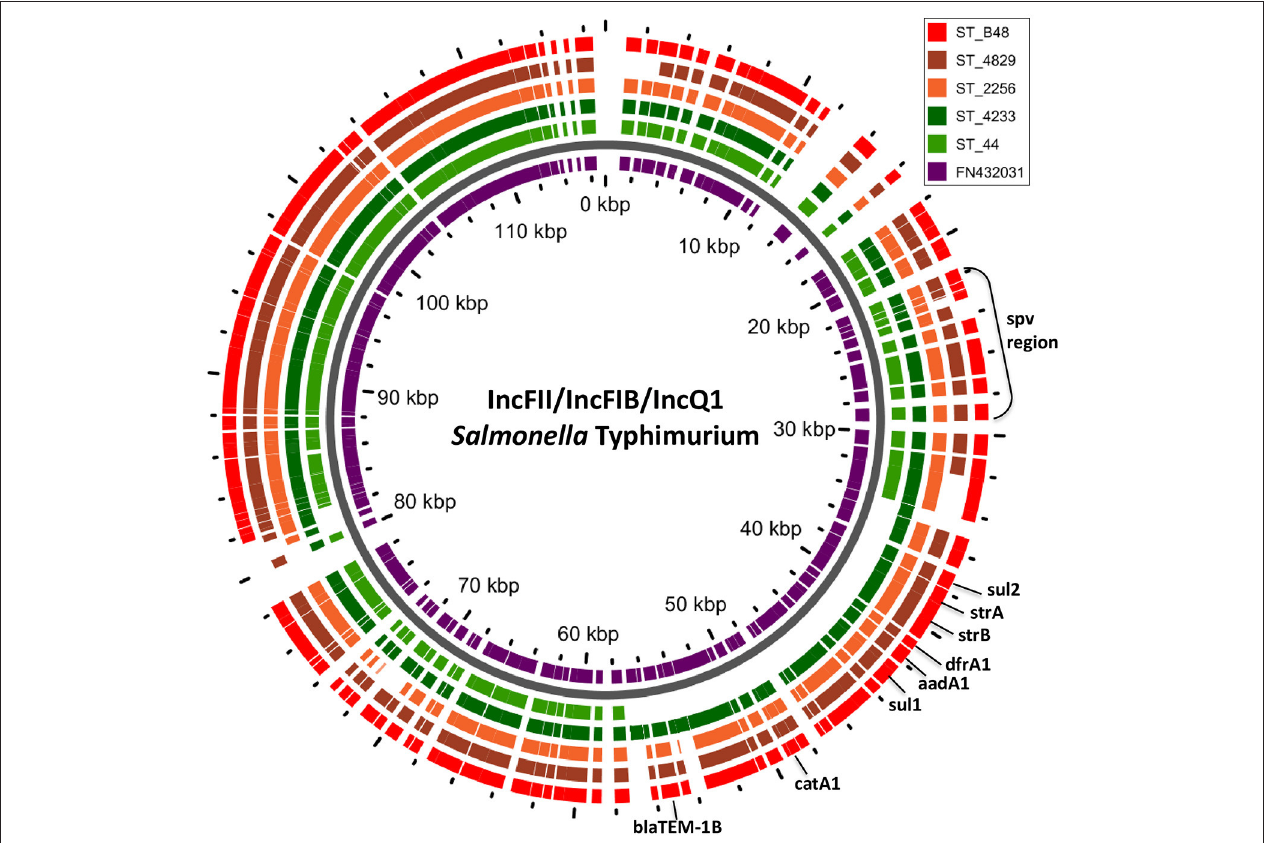
FIGURE 2 | BLAST ring of IncFII(S)/IncFIB(S)/IncQ1 plasmid homologs of Salmonella Typhimurium and reference plasmid FN432031. Blast ring was created with GView. The middle ring is a reference plasmid, around which BLAST lanes are shown. Every lane corresponds to plasmid in each genome. The location of spv virulence-associated region, and antibiotic resistance genes are indicated outside the